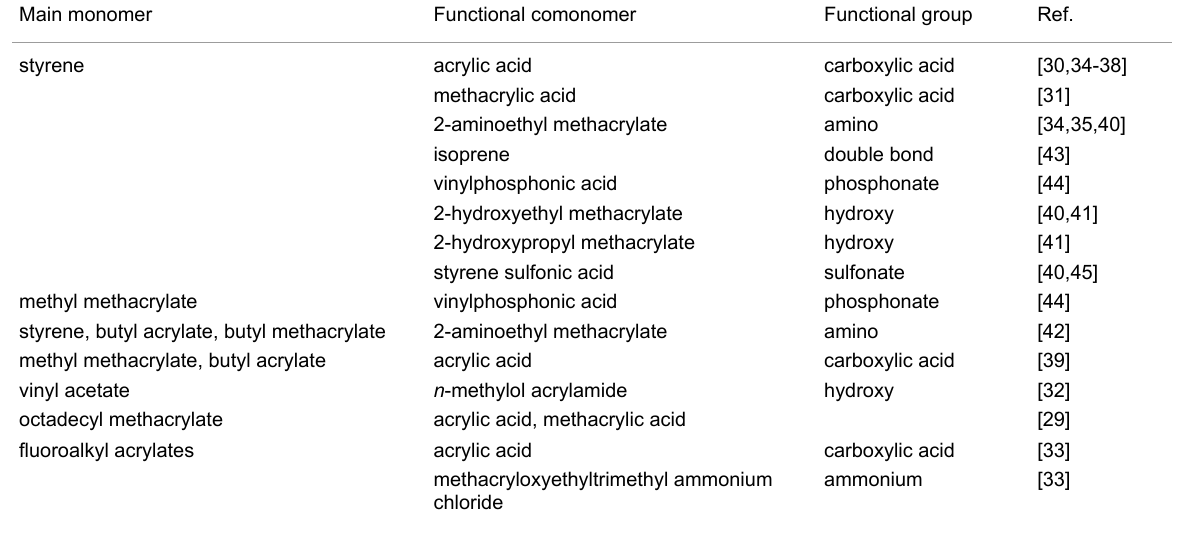
Table 3: Functional comonomers employed in polymerizations with styrene, (meth)acrylates, and vinyl acetate in direct miniemulsion. Main monomer